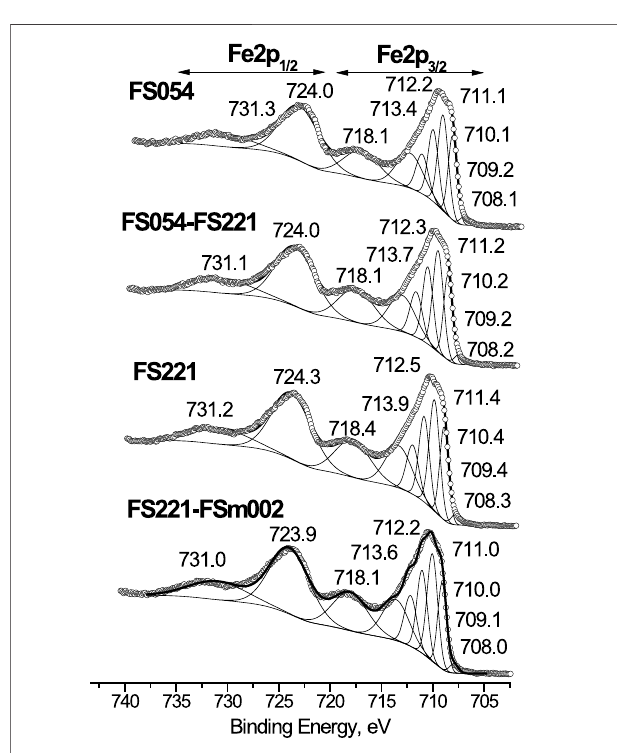
FIGURE 5 | Fe2p XPS spectra of catalysts before